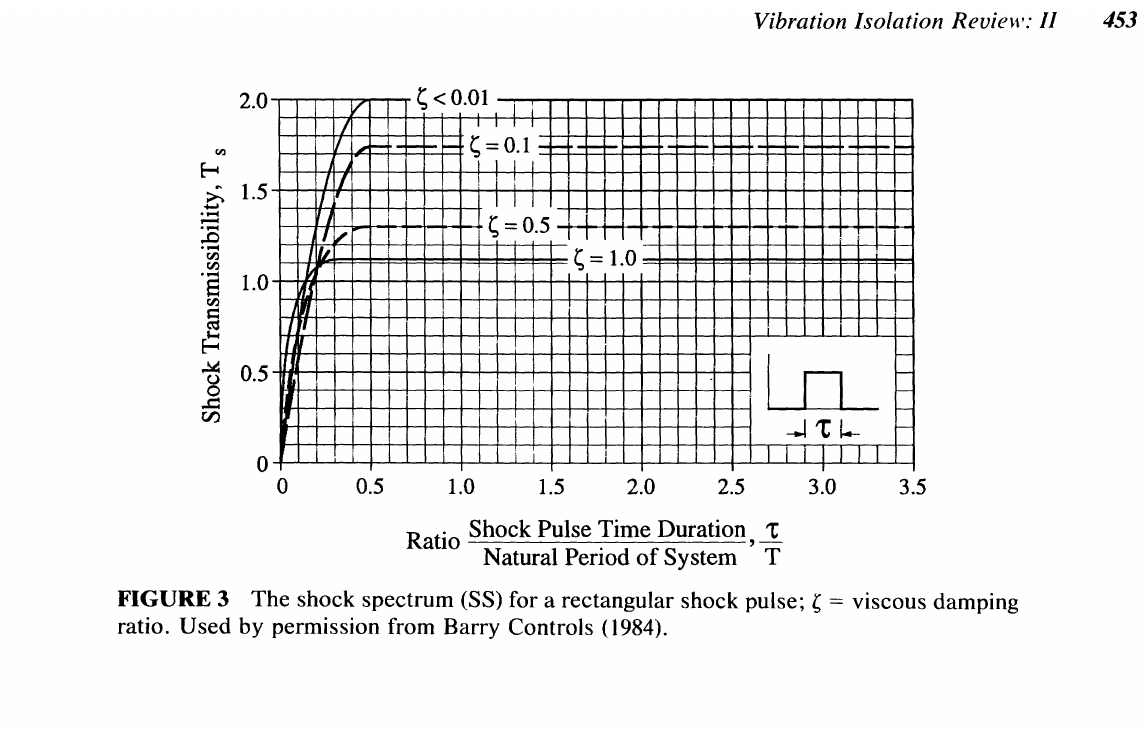
FIGURE 3 The shock spectrum (SS) for a rectangular shock pulse; ~ = viscous damping ratio. Used by permission from Barry Controls